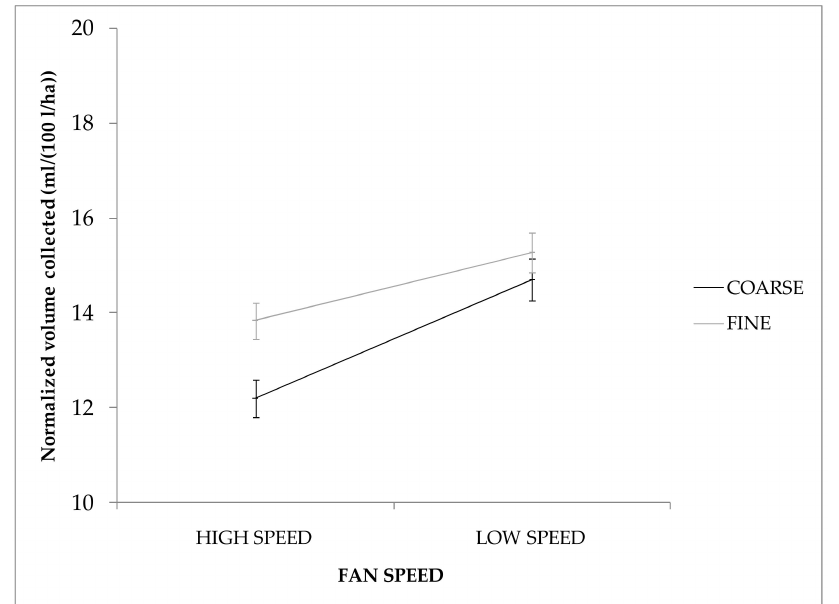
Figure 22. Nozzle type × Fan speed interaction effect on the normalized volume collected in the canopy zone (mean ± SE) with the C2 sprayer.